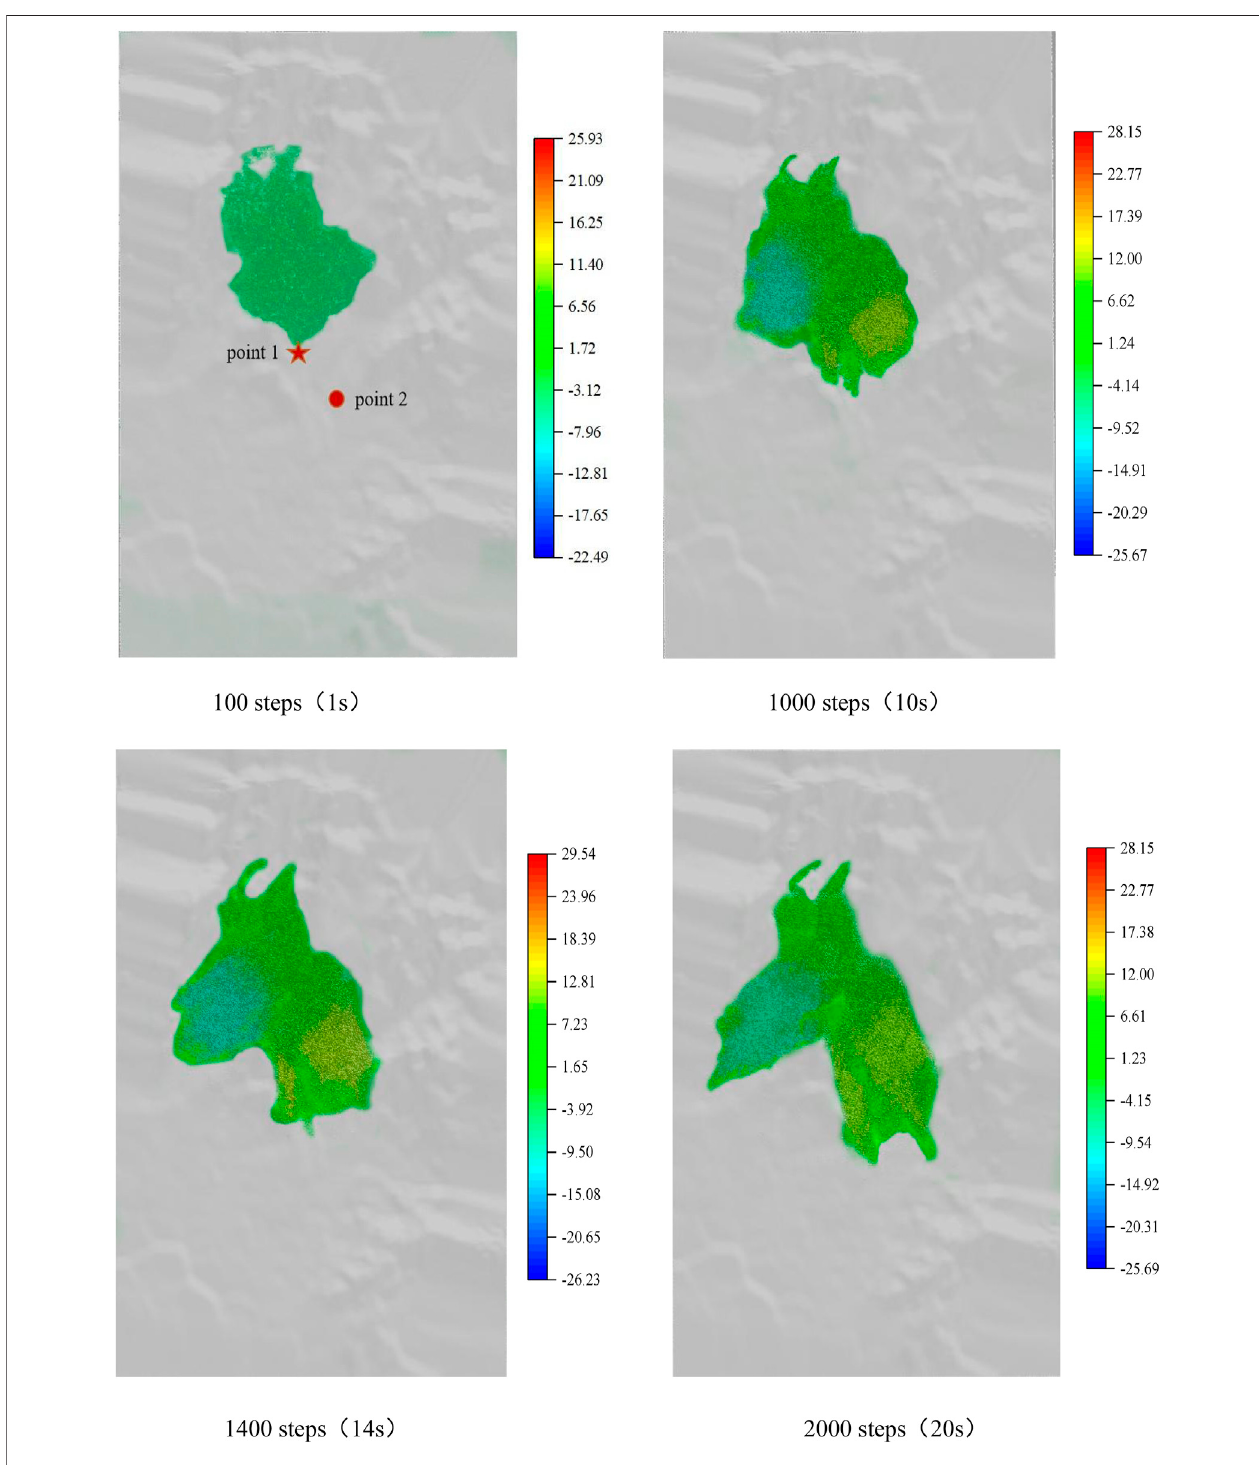
FIGURE 8 | Simulation results of tailings dam failure range at different